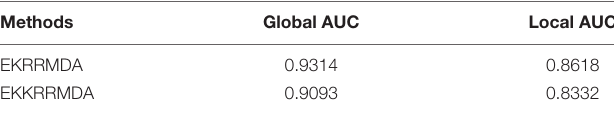
TABLE 2 | Comparison of global AUC and local AUC between EKRRMDA and EKKRRMDA under LOOCV.